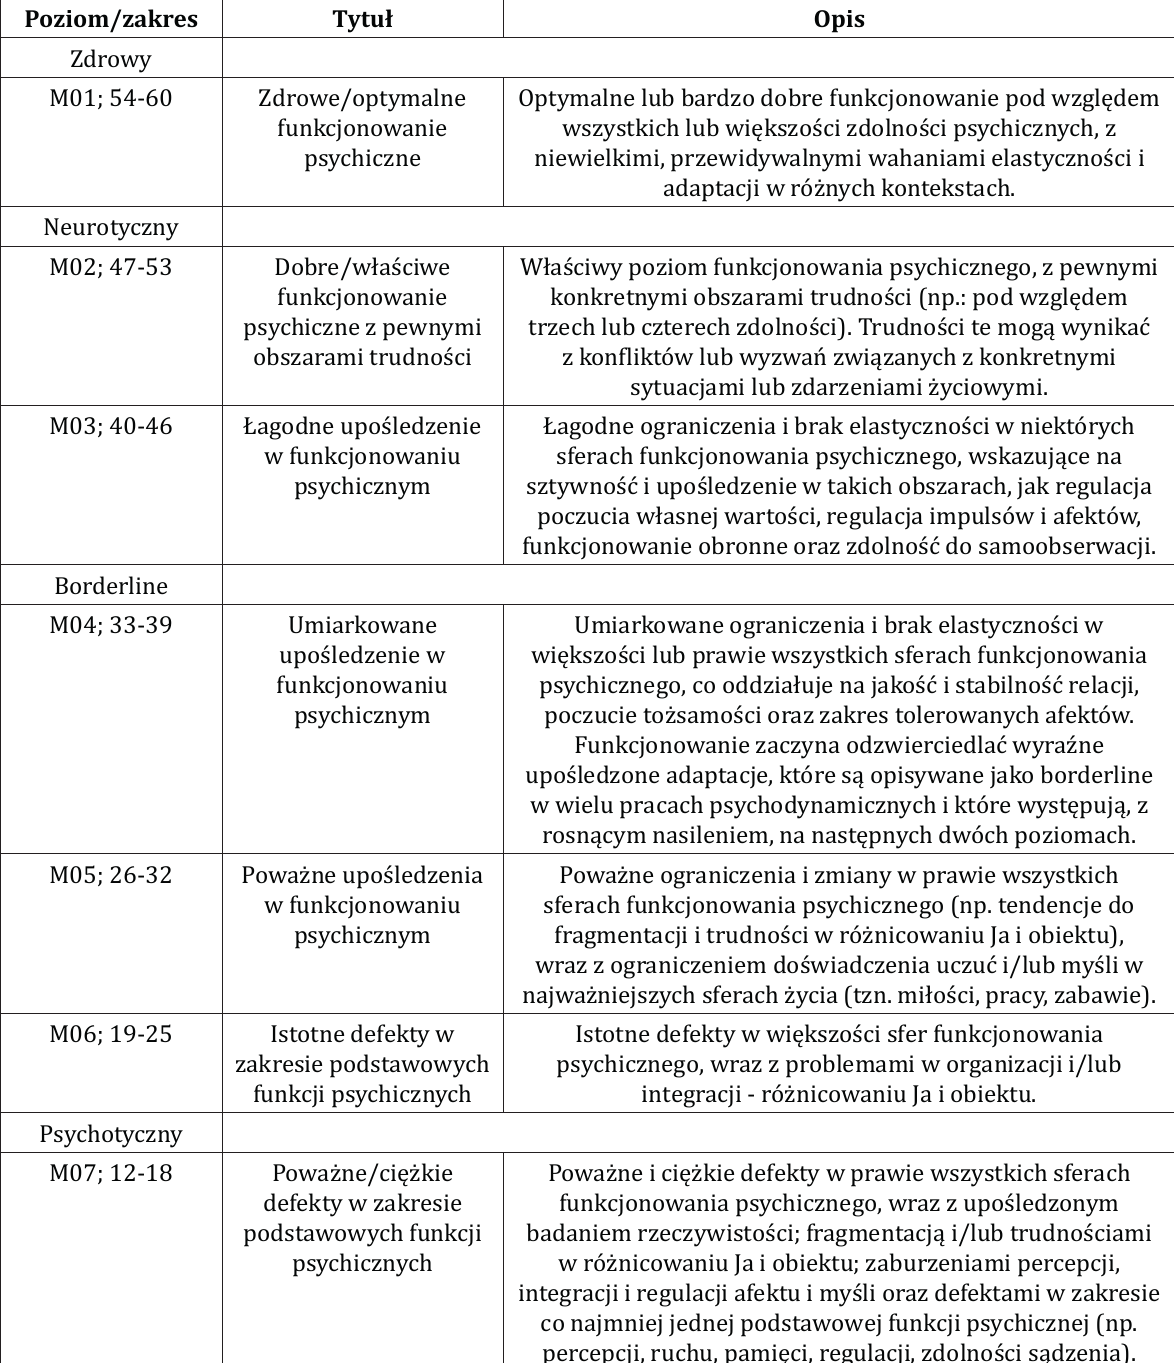
Tabela 3. Poziom zdolności na osi M (źródło: [3]) Poziom/zakres